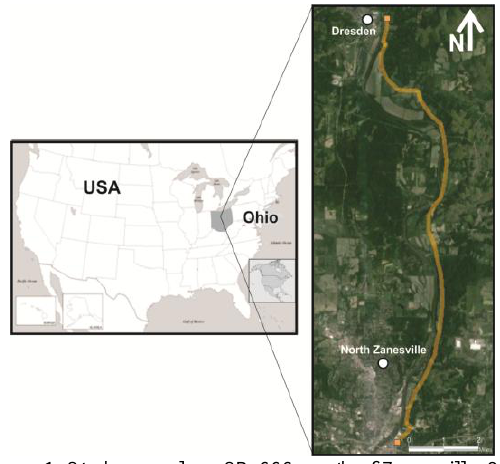
Figure 1. Study area along SR-666, north of Zanesville,